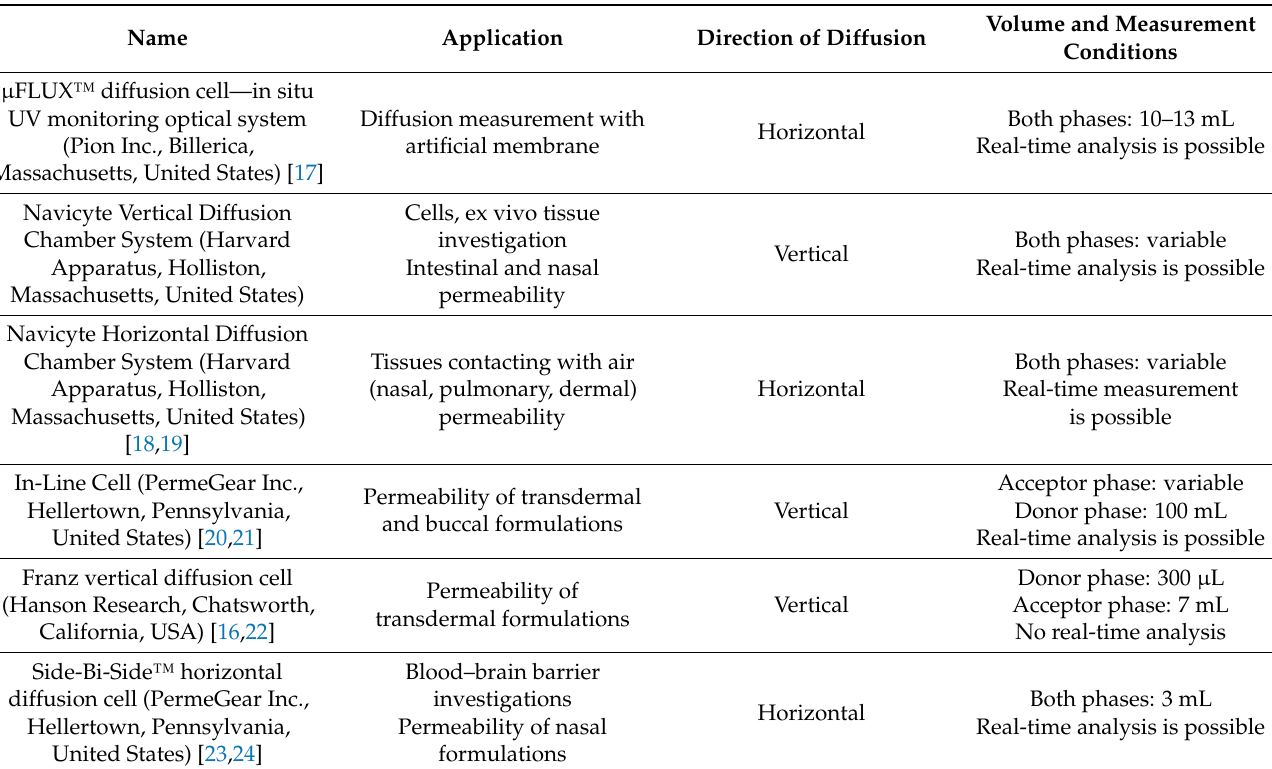
Table 1. The most commonly used in vitro diffusion investigation